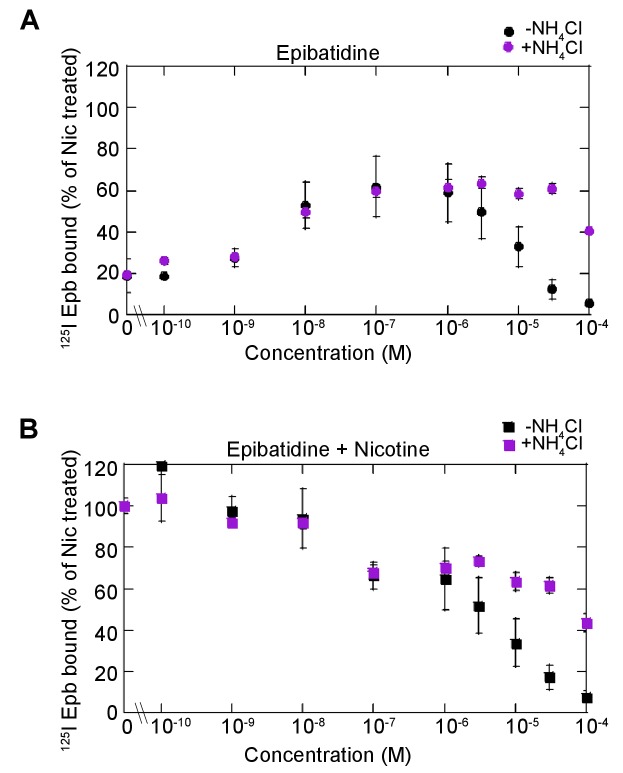
Dose dependence of epibatidine effects on upregulation.(A) Dose dependence of epibatidine upregulation. α4β2R-expressing cells were treated with increasing concentration of epibatidine for 17 hr. Cells were washed with PBS prior to 125I-epibatidine binding and with (magenta-filled circles) or without 20 mM NH4Cl (black-filled circles) treatment for 10 min (n = 3). (B) Dose dependence of epibatidine on nicotine upregulation. Cells were treated with increasing concentration of epibatidine with 10 μM nicotine for 17 hr and treated with (magenta -filled squares) or without 20 mM NH4Cl (black-filled squares) treatment for 10 min as in (A) (n = 3). For all the points in (A, B): error bars represent mean ± s.e.m. n indicates number of independent experiments performed on separate days and cultures.